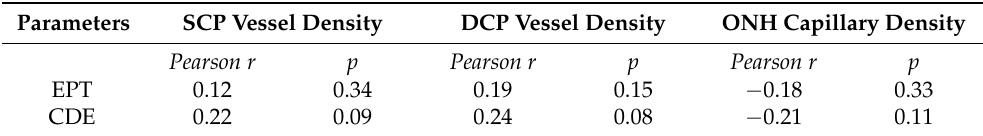
Table 3. Regression analysis to correlate EPT and CDE with variations SCP vessel density, DCP vessel density and ONH capillary density.